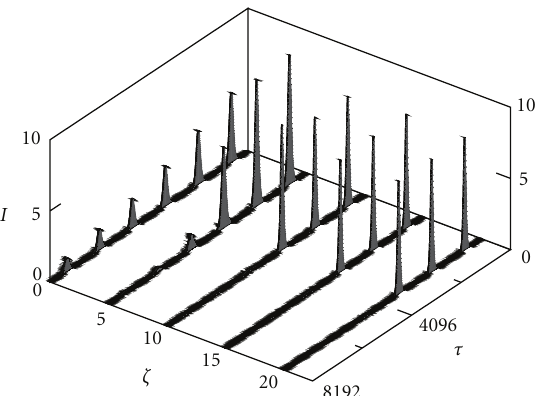
Figure 2: Transient evolution of the field in the fiber laser. The temporal distribution of the intracavity intensity I ( τ ) versus the round-trip number ζ . a = 3, b = 0 . 017, q = 1, D i = − 1, D r = D r 0 G , D r 0 = 0 . 34, α 0 = − 1 . 1, α 3 = − α 1 = 0 .